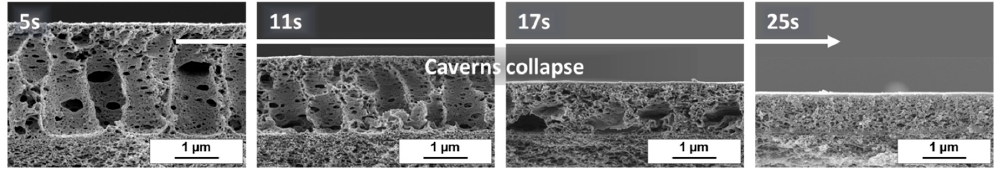
Figure 6. Cross-sectional image of a PS 83 - b -P4VP 1788k gradient sample at the position of 5 s, 11 s, 17 s and 23 s (left to right) evaporation time.